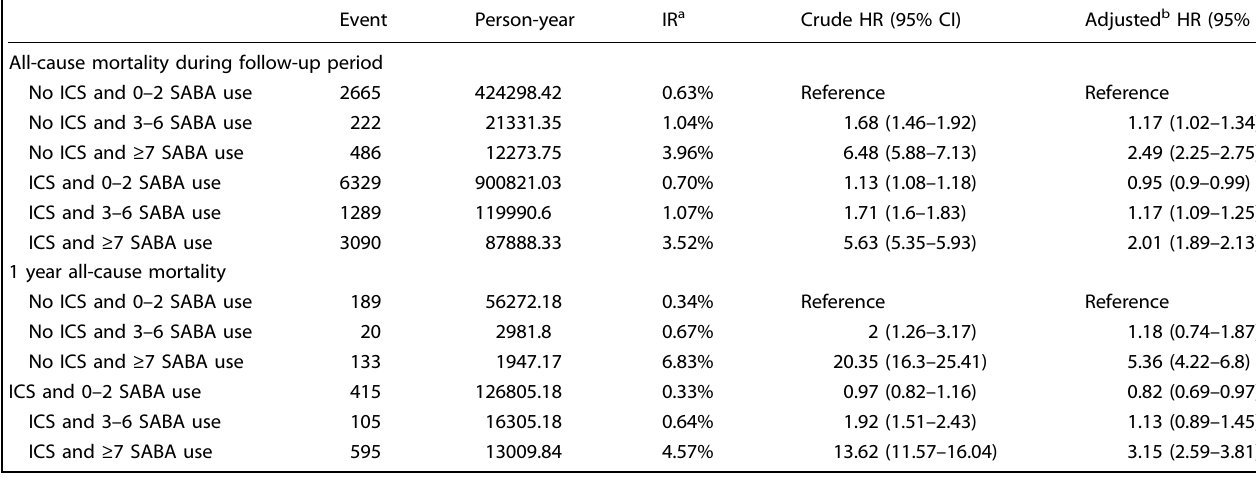
Table 4. Association between baseline ICS and SABA use and risk of all-cause mortality.